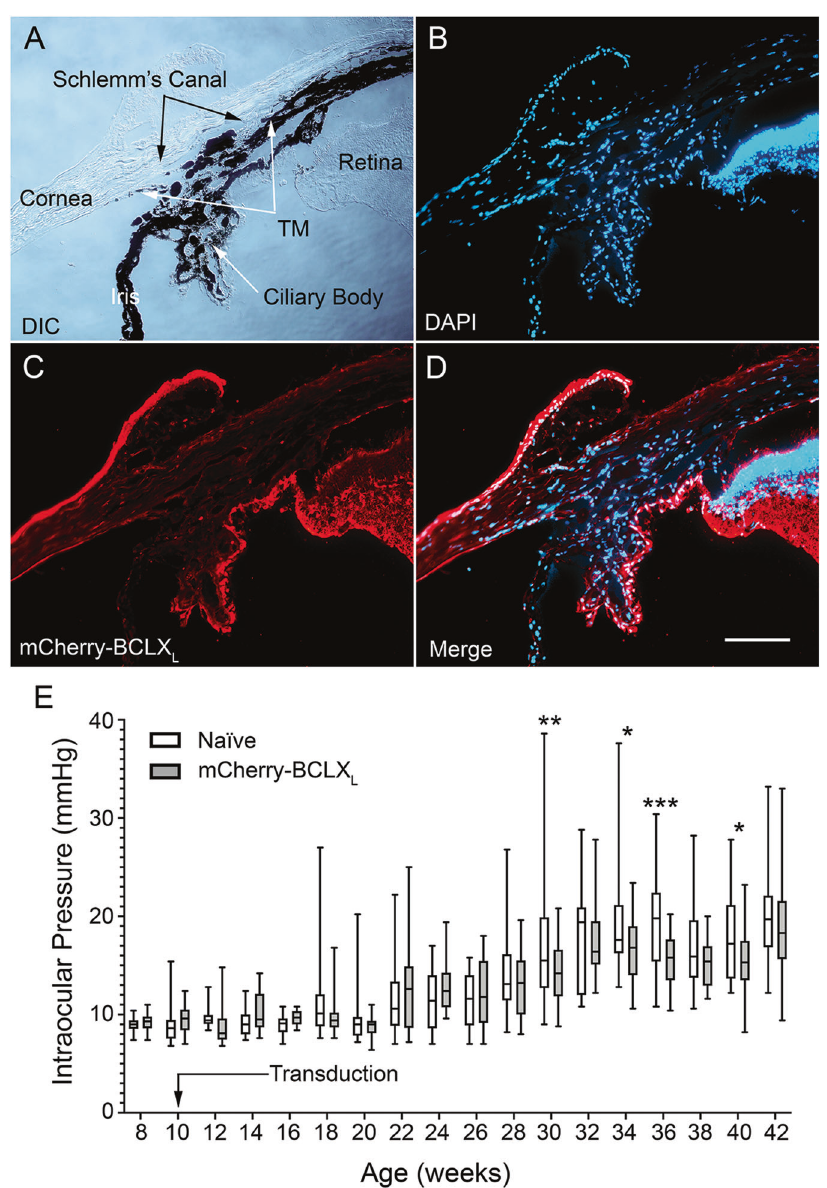
Fig. 5 AAV2-Pgk-mCherry-BclXL gene therapy does not alter the progression of ocular hypertension in DBA/2J mice. A Bright fi eld image showing the relevant ocular anatomy for the out fl ow pathway of an eye that was transduced with AAV2-Pgk-mCherry-BclX L . B – D Fluorescent images showing the DAPI-positive nuclei ( B ) and the expression pattern of mCherry-BCLX L ( C ), as well as a combined view of B , C ( D ). Note that an mCherry antibody was used to amplify the mCherry-BCLX L signal. Expression is seen strongly in the retina and ciliary body but is not present in Schlemm ’ s canal, the iris, or the trabecular meshwork (TM). The exterior surface of the cornea also appears to be expressing mCherry-BCLX L , which may be the result of viral particles fl owing onto the surface of the eye when the needle is removed from the eye during the intravitreal injection. E Intraocular pressures of AAV2-Pgk-mCherry-BclX L transduced and naive DBA/2J mice that were measured every 2 weeks from the age of 8 to 42 weeks. Transduction occurred the day after the second measurement of IOP when the mice were 10 weeks old. The data are represented as box and whisker plots with the mean shown as a bar in the center of the data, the 25th and 75th percentiles shown as the edges of the box, and the whiskers extending to show the minimum and maximum values for the data. For IOP measurements, N = an average of 18 eyes per group per time point. Generalized Estimating Equation regression modeling was used to assess the statistical difference between the IOPs of the groups at each timepoint and longitudinally. Individual timepoints that are statistically different from one another are shown. * P < 0.05, ** P < 0.01, *** P < 0.001. Regression analysis performed on the data show that the longitudinal IOP progression of the naive and mCherry-BCLX L groups are RESULTS using a ×40 magni fi cation oil objective. Images were scored using a semi-quantitative three-score system where each nerve was assigned a mCherry - BCLX L prevents GFP-BAX recruitment in vitro score of No or Early (NOE), Moderate (MOD), or Severe (SEV) glaucoma The canonical function of mCherry - BCLX L of preventing BAX [20]. All ONs were scored by two masked observers. The statistical from accumulating on the mitochondria was veri fi ed in vitro. As signi fi cance between the distributions of different groups was calculated expected, mCherry-BCLX L colocalized with a mitochondrially using χ 2 test.